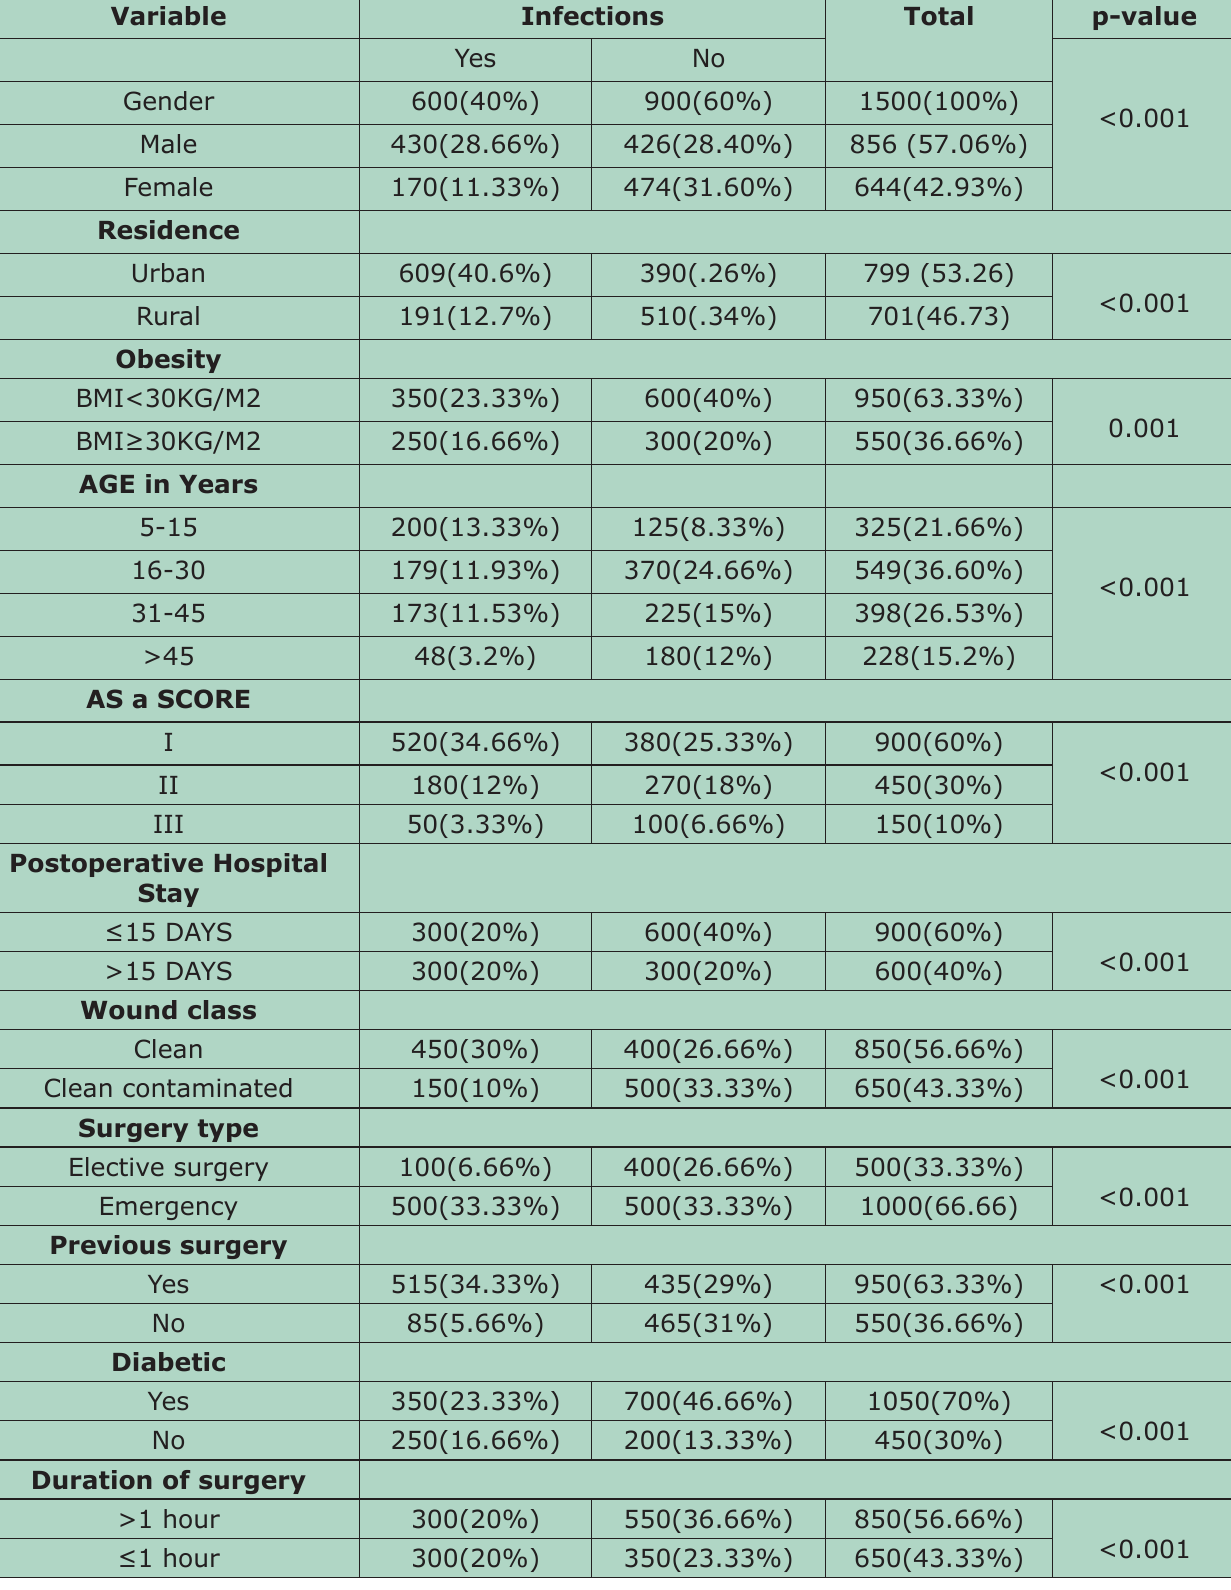
Table-IV: Association between Postoperative Infection and other